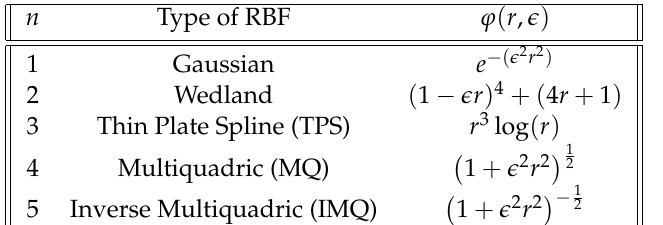
Table 1. Commonly used radial basis